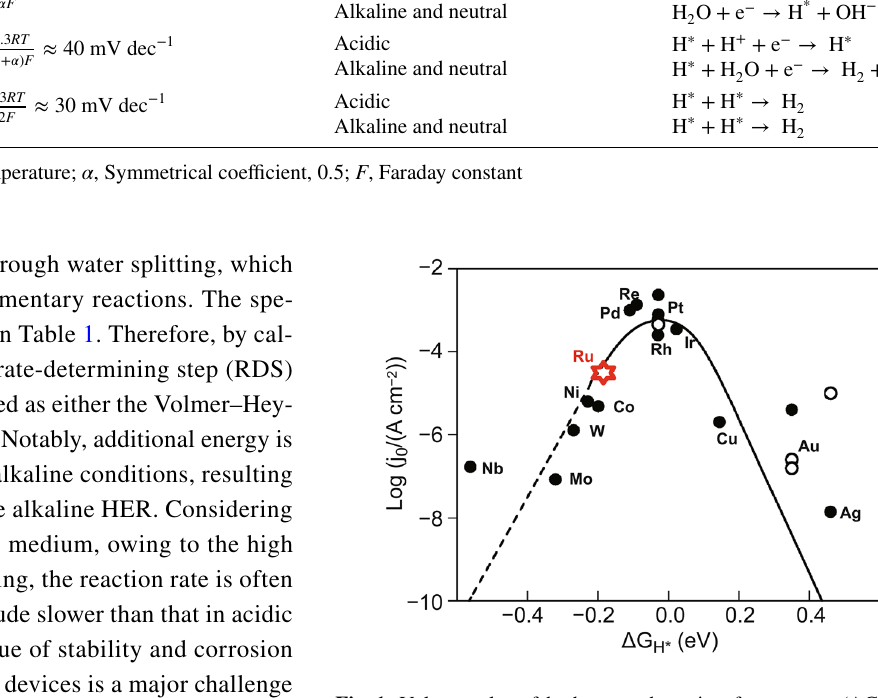
Fig. 1 Volcano plot of hydrogen adsorption free energy (ΔG H* ) of different metal catalysts in HER. With the exception of Ru, the data for the other metals are from the summary of Nørskov et al. High H coverage of metals on the left side of the volcano (1 monolayer (ML)), lower on the right side (0.25 ML). The dashed line indicates that the metals which bind H stronger than 0.2 eV H −1 usually form oxides at U = 0 V. The open circles are (111) data, whereas the filled circles are polycrystalline [25]. The data of Ru are from Hoster et al., corresponding to the calculation data of Ru (0001) at 1.1 ML [24]. With permission from the American Chemical Society and Springer